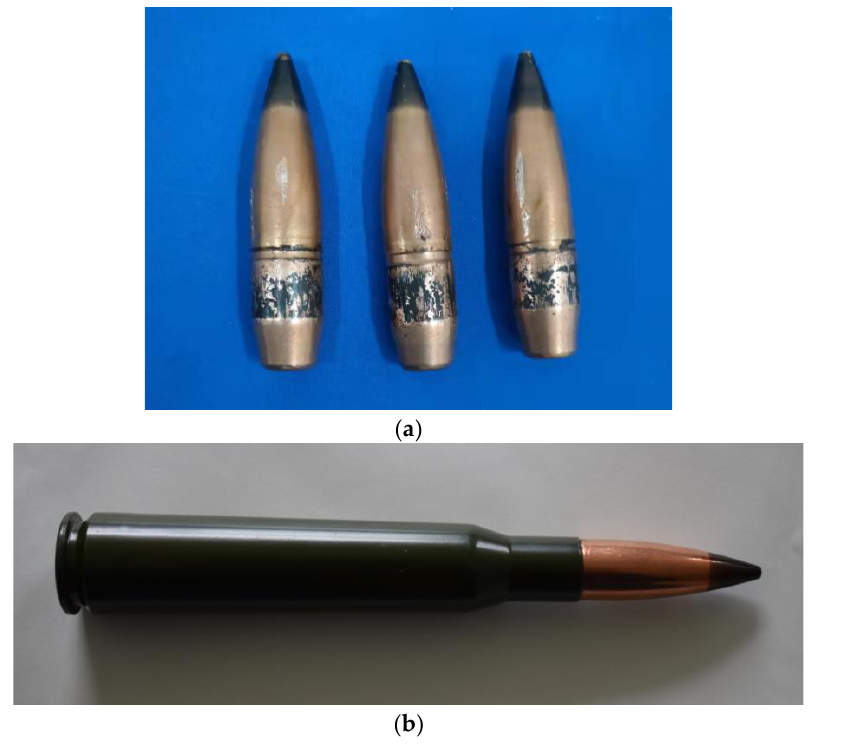
Figure 3. State of the projectile in the experiment. ( a ) 14.5 mm caliber A – P projectile. ( b ) Assembly of the projectile in the cartridge.